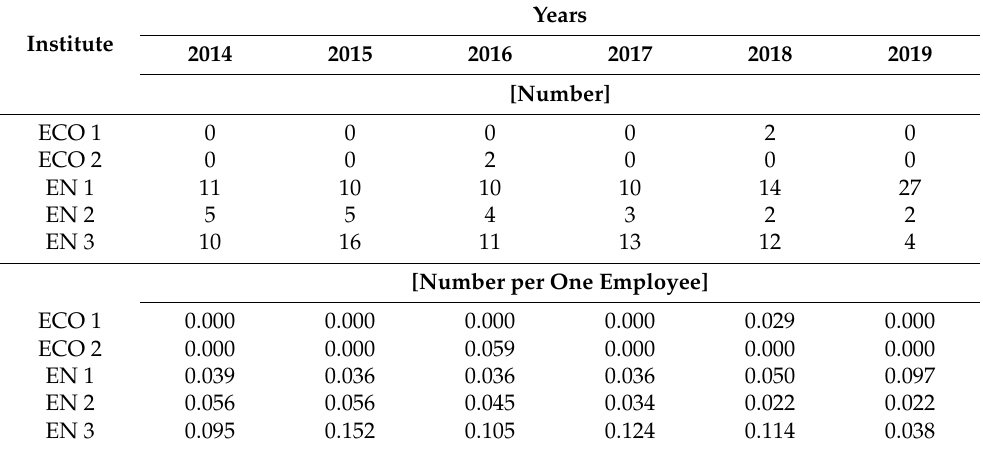
Table 5. Total number of patents per one employee in the studied research institutes in the years